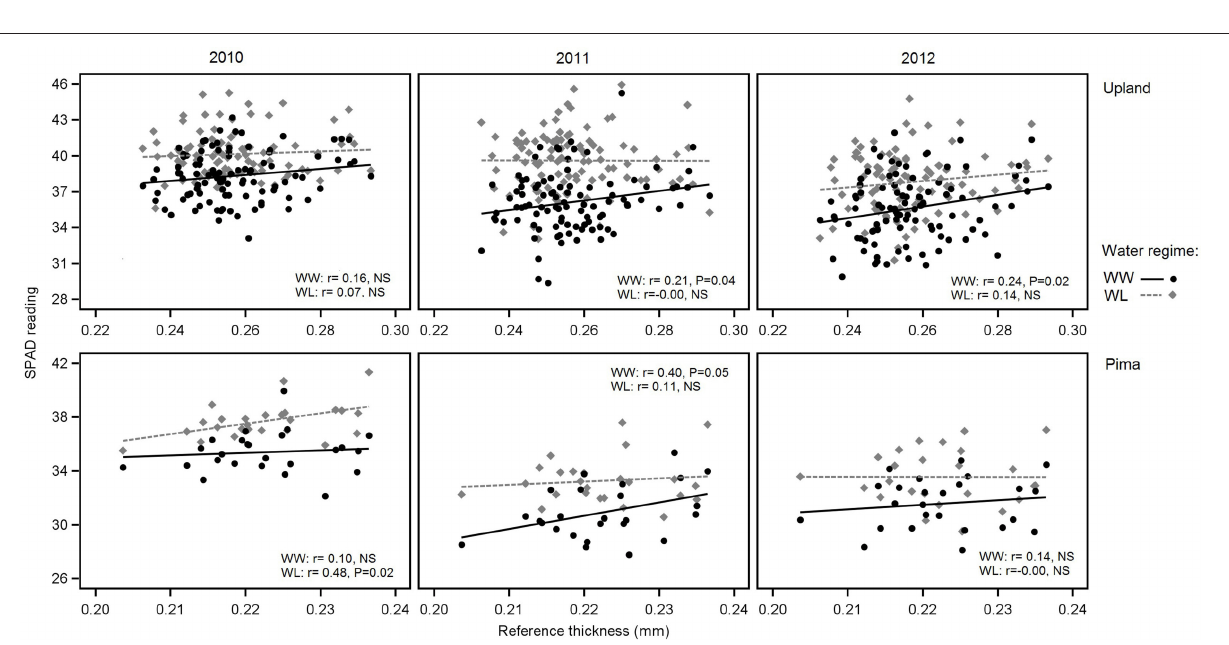
FIGURE 3 | Variation in NDVI in relation to reference leaf thickness for 2010, 2011, and 2012 and the two irrigation regimes. The upper three graphs are for upland RILs, and the lower three are for the Pima diversity panel. Lines indicate regression trends for each irrigation regime. Note difference in scales for upland vs. Pima graphs.